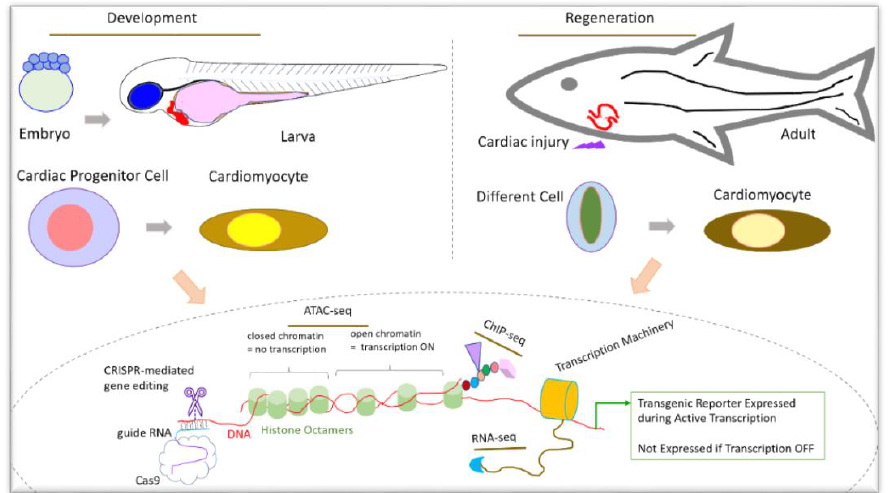
Figure 2. Zebrafish is an excellent model to study development and regeneration using state-of-the- art high-throughput technology. Zebrafish has several advantages to support ATAC-seq, RNA-seq, ChIP-seq, transgenic reporter line generation, gene editing by CRISPR, etc. Keys: ●●●—amino acid residues on N-terminal histone tails. (cid:3) , ∆ —histone